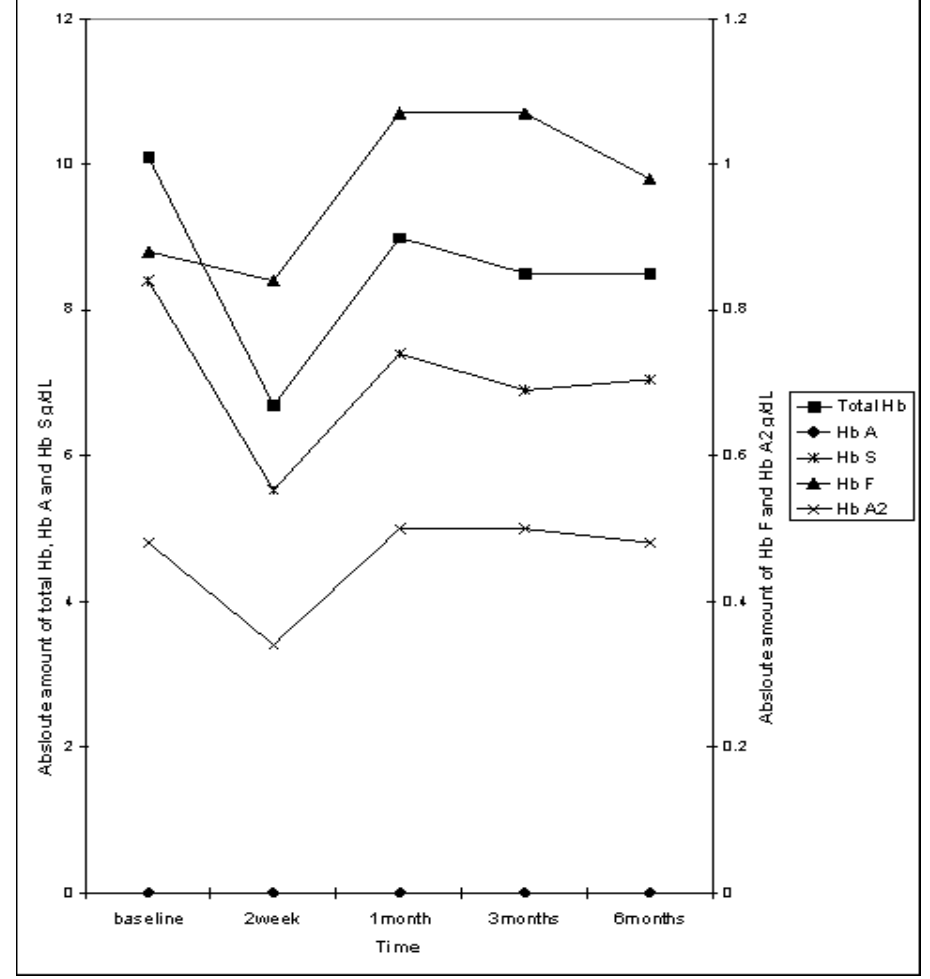
FIGURE 3 . Hemoglobin type changes at 2 weeks, 1, 3, and 6 months postinfusion of the RSC into a patient with beta-thalassemia/sickle cell disease when compared with baseline. This patient never received a blood transfusion pre- or postinfusion of the